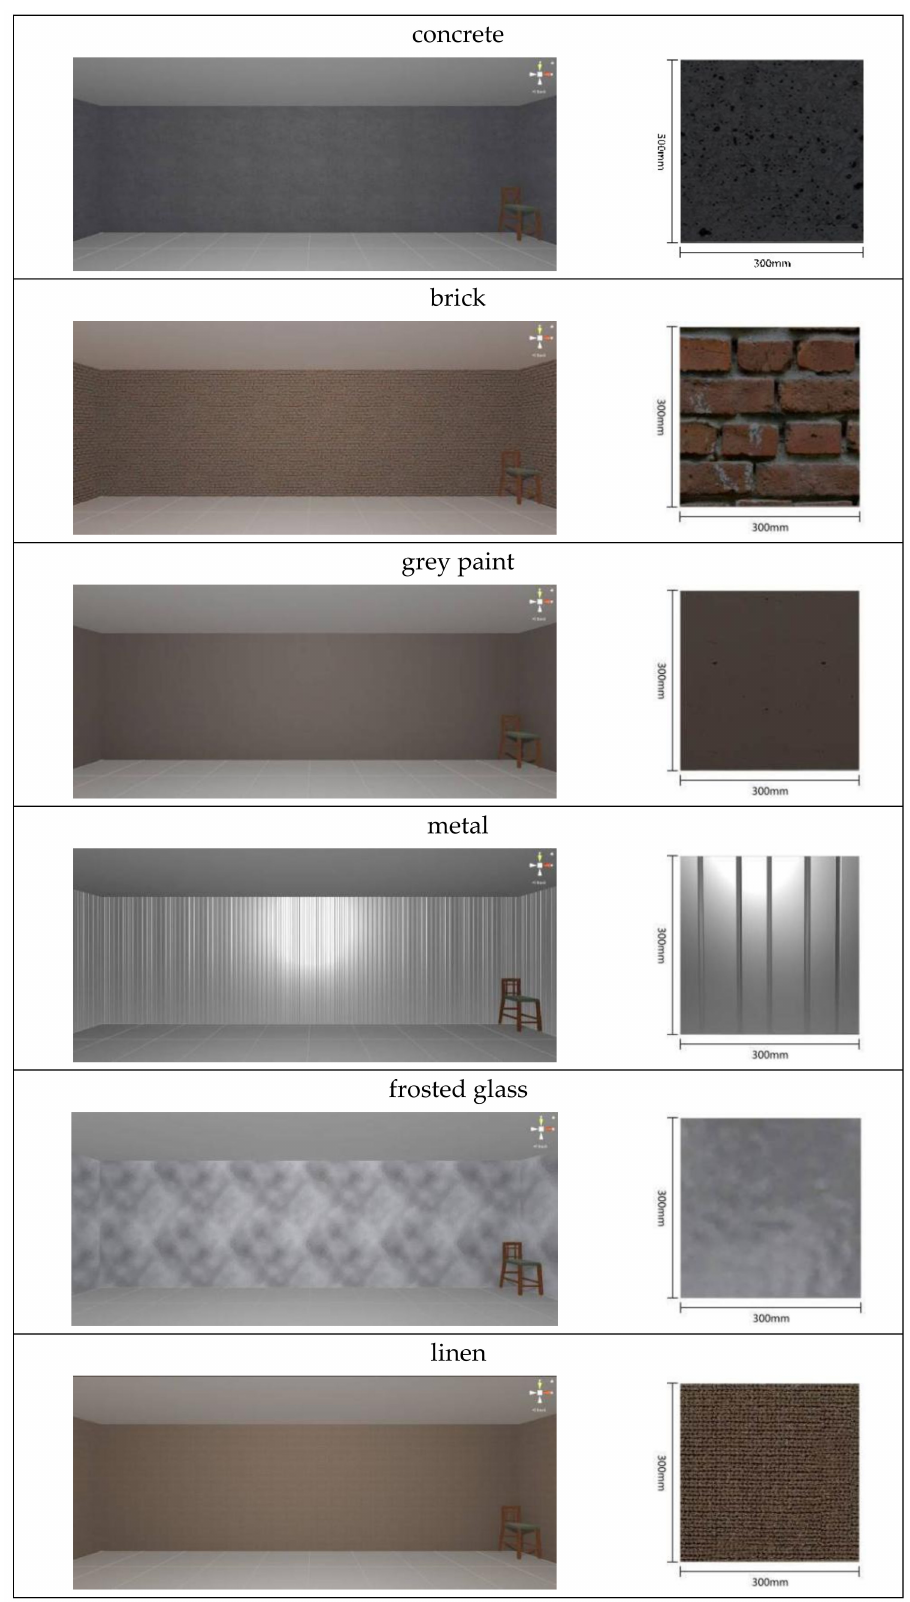
Figure 1. Relative stimuli for Experiment